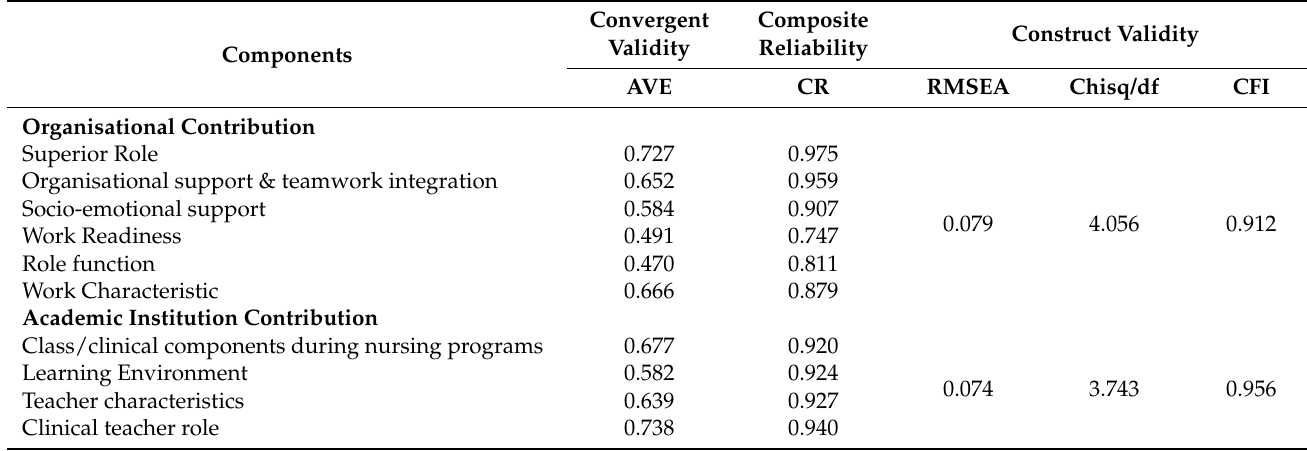
Table 2. The CFA report for construct validity, convergent validity, and composite reliability.